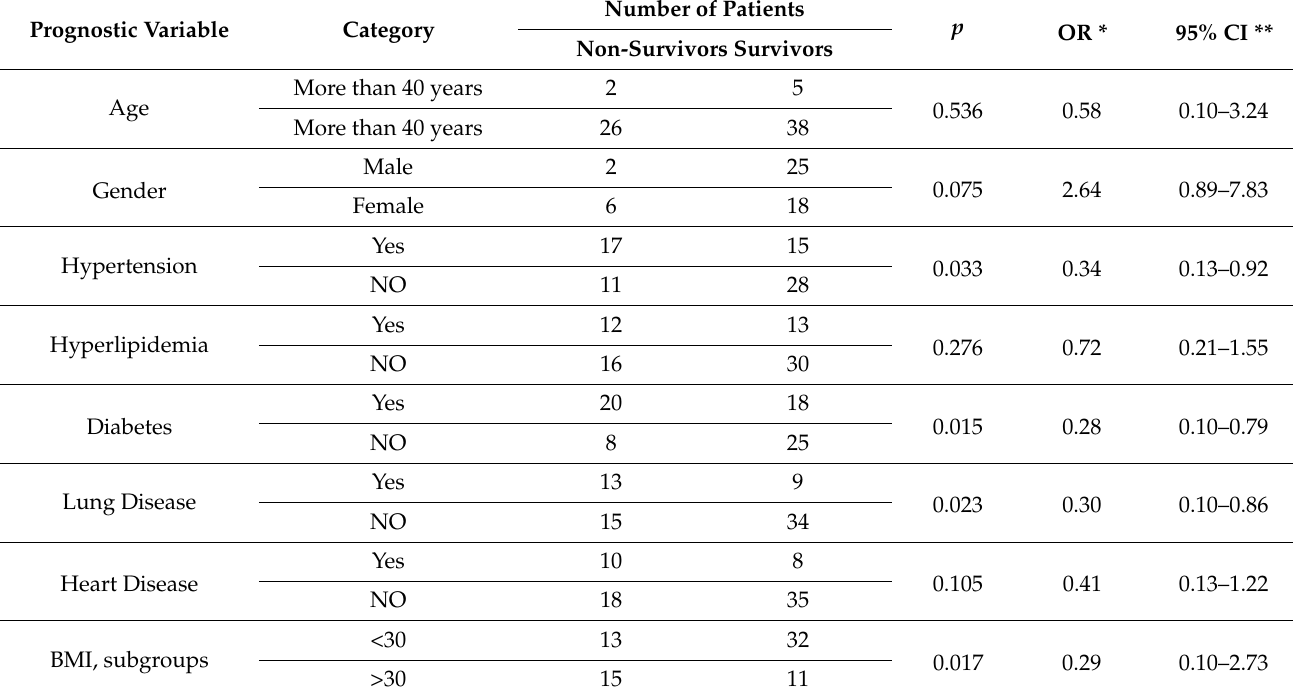
Table 3. The association between the prognostic risk factors and mortality after tracheostomy.